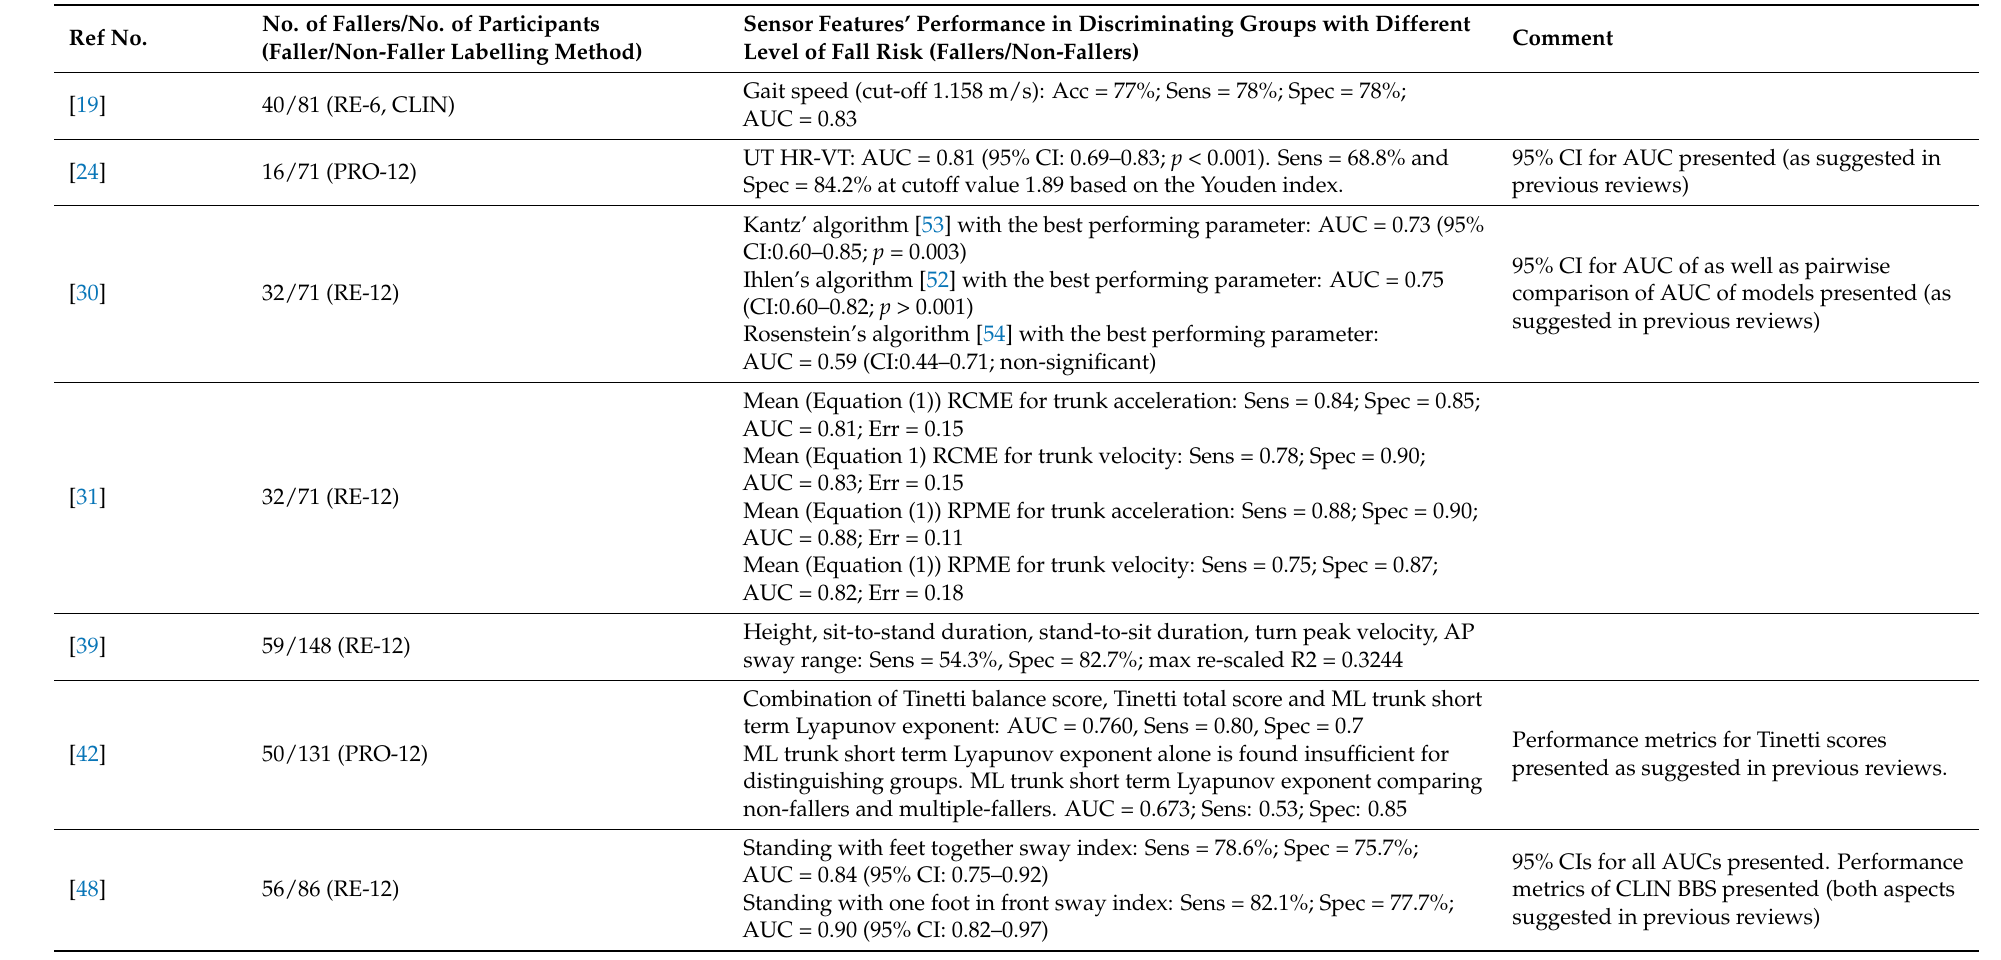
Table 9. Statistical analyses on the sensor-based features’ performance in classifying older individuals according to their risk of falling. Acc = Accuracy, BBS = Bergs Balance Scale, Err = Error, Sens = Sensitivity, Spec =